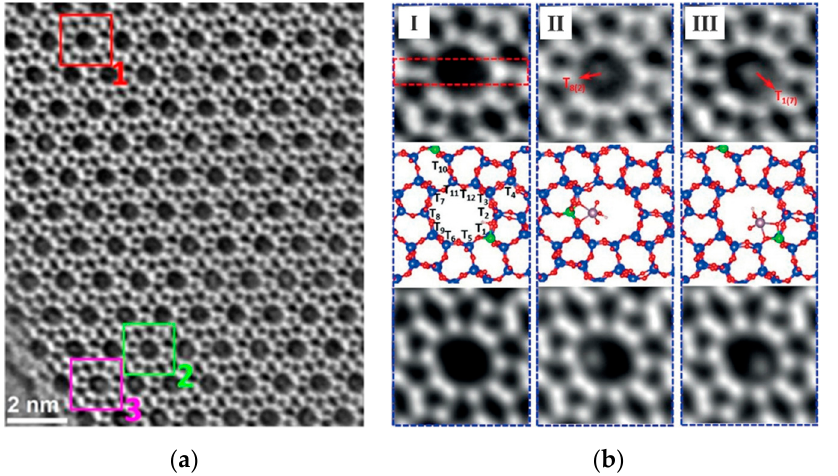
Figure 12. ( a ) iDPC-STEM image of Mo/ZSM-5; ( b ) Zoomed-in areas 1 (I), 2 (II), and 3 (III) of ( a ) with an atomic model. Reprinted/adapted with permission from Ref. [99]. Copyright 2019, Angewandte Chemie.